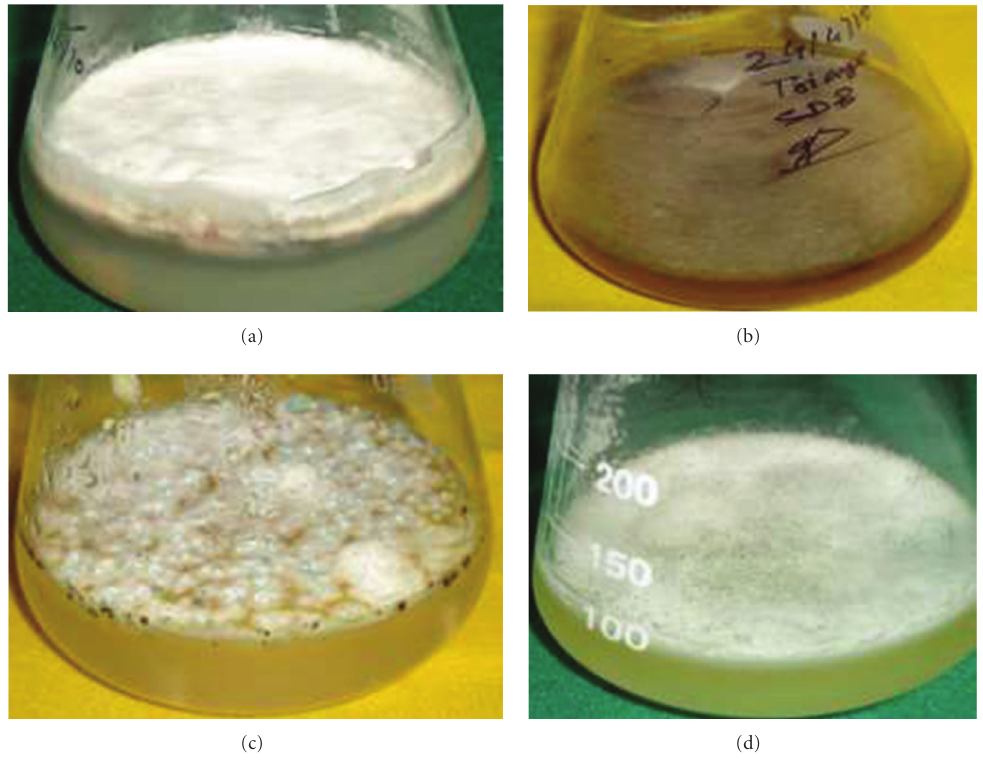
Figure 1: The culture of (a): Fusarium oxysporum , (b): Trichophyton ajelloi , in Suboraud dextrose broth, (c): Lagenidium giganteum , and (d): Culicinomyces clavisporus in EmYPss broth maintained in laboratory.